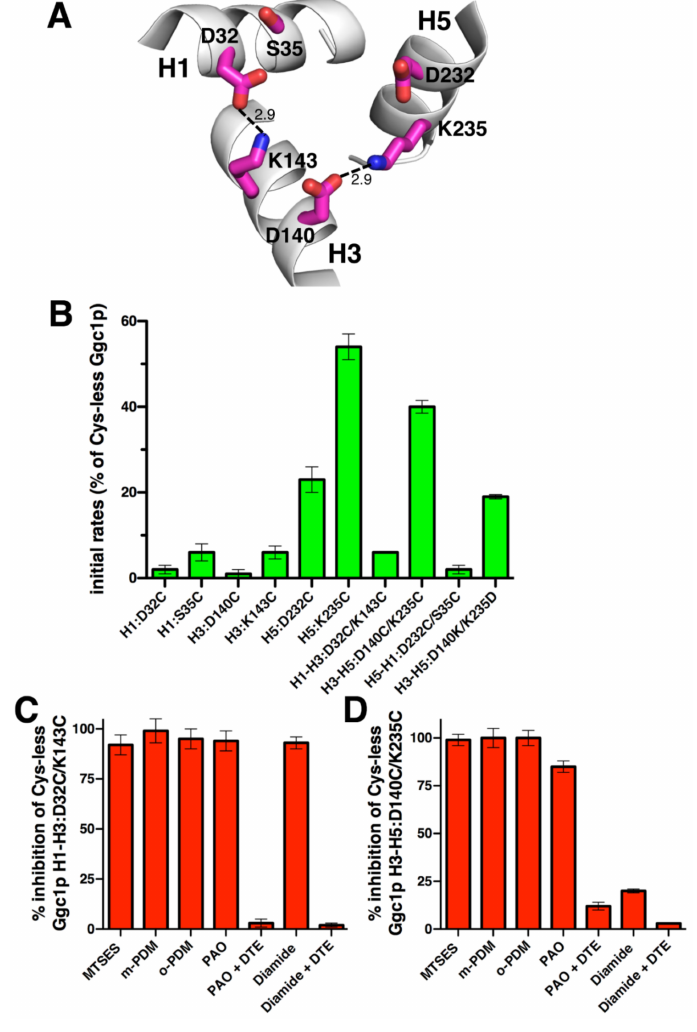
Figure 3. Initial transport rates of the Ggc1p cysteine mutants. ( A ) The PX[DE]XX[KR] motifs in the C-state Ggc1p homology model with the salt bridges indicated by lines and distances in Å. ( B ) Initial transport rates of Cys-less Ggc1p cysteine mutant proteins reconstituted in liposomes. Transport was started by adding 100 µ M of 3 H-GTP to proteoliposomes containing 5 mM GTP and stopped after 30 sec by the stop inhibitor method. The activity is expressed as the percentage initial rate of Cys-less Ggc1p, which was 35678 ( ± 672) µ mol/min/g protein. The means ± S.D. of at least three independent